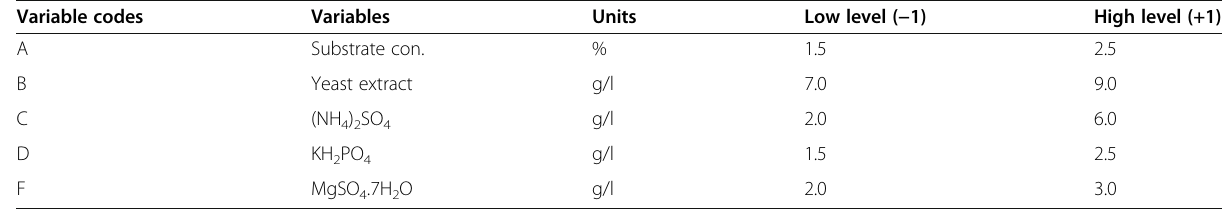
Table 1 Variable codes and their levels employed in the two-level factorial design for screening of medium components affecting xylanase production by Aspergillus oryzae MN894021 Variable codes